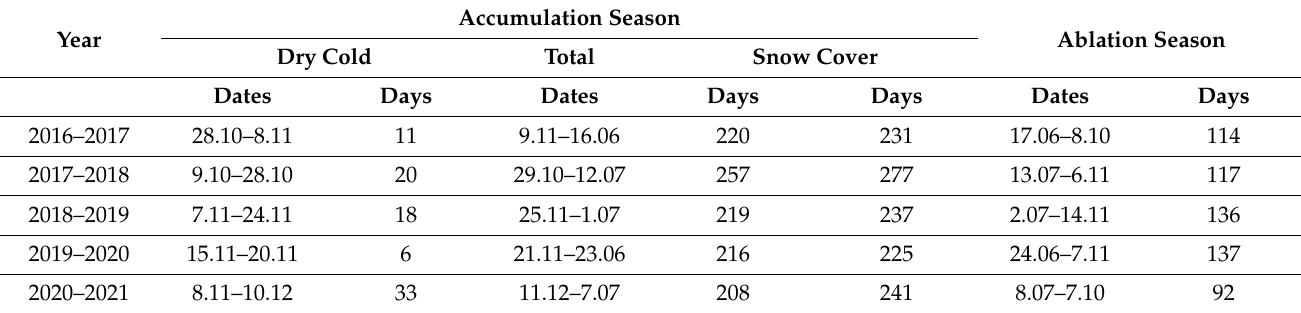
Table 5. Actual duration of accumulation and ablation seasons according to the data of the ground temperature at Snezhnika glacieret.